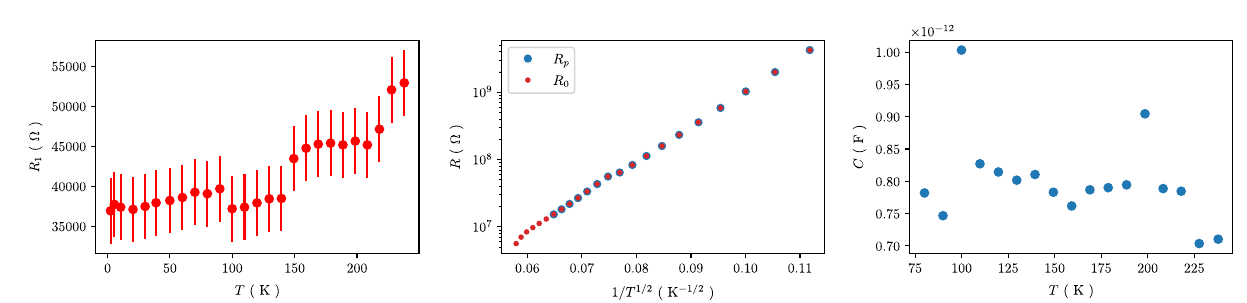
Figure 5. Frequency dependencies of real (left) and imaginary parts (right) of impedance for all samples at selected temperatures as indicated. The black lines are results of a lumped circuit fit; see inset for circuit model. See text for details.